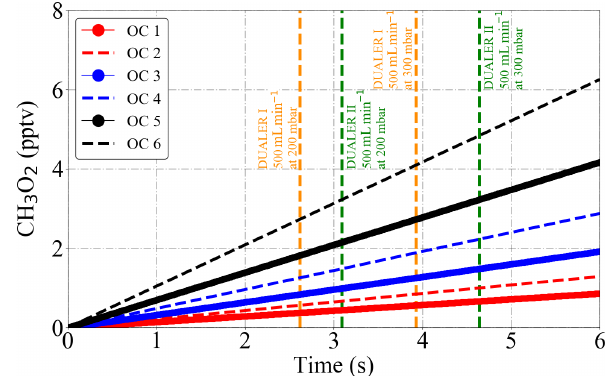
Figure 11. CH 3 O 2 radical production from the thermal decompo- sition of 1ppbv PAN as simulated by a box model between 288 and 298K at 200 and 300mbar. OC1: 288K and 300mbar; OC2: 288K and 200mbar; OC3: 293K and 300mbar; OC4: 293K and 200mbar; OC5: 298K and 300mbar; OC6: 298K and 200mbar. The sample residence times for 500mLmin − 1 sample flow in the DUALER I and II are also depicted for